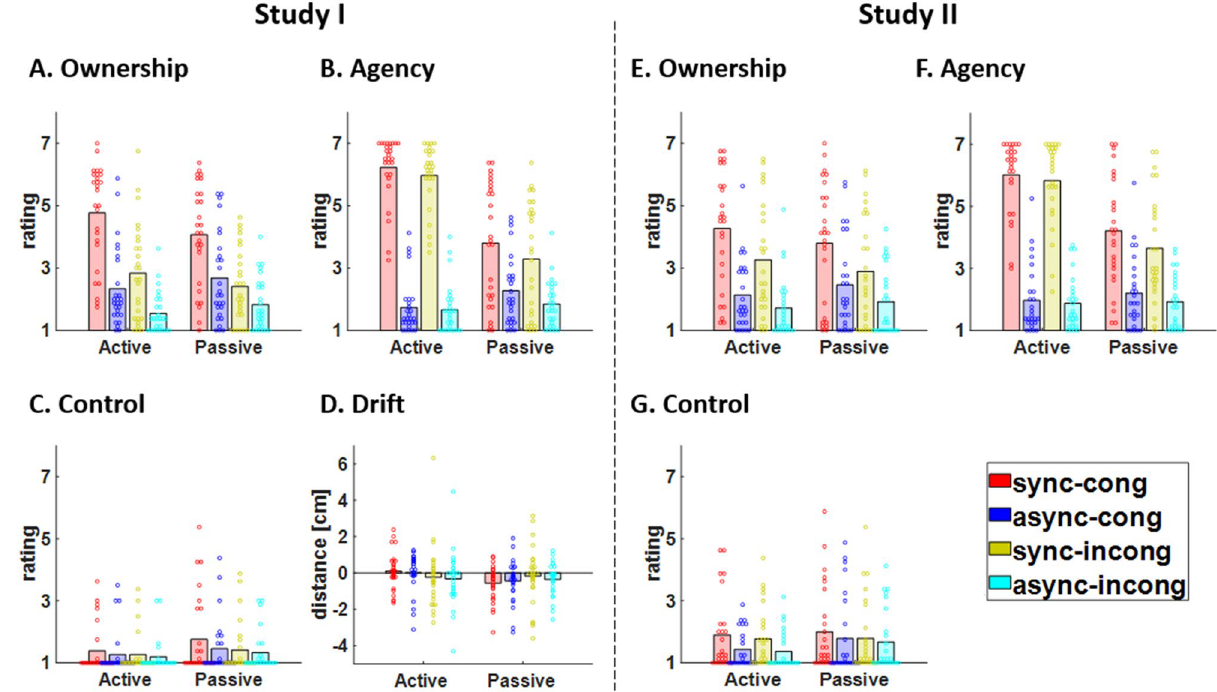
Figure 1. Questionnaire results. ( A ) Average raw SO ratings for Study I, rated from 1 (least SO) to 7 (greatest SO). ( B ) Average raw SA ratings for Study I. ( C ) Average raw control ratings for Study I. ( D ) Average proprioceptive drift for Study I. ( E ) Average raw SO ratings for Study II. ( F ) Average raw SA ratings for Study II. ( G ) Average raw control ratings for Study II. For all results, the 8 experimental conditions follow a 2 × 2 × 2